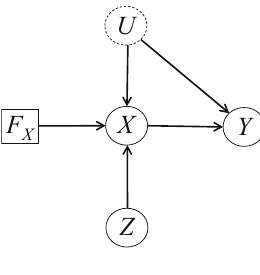
Figure 2: Instrumental variable with